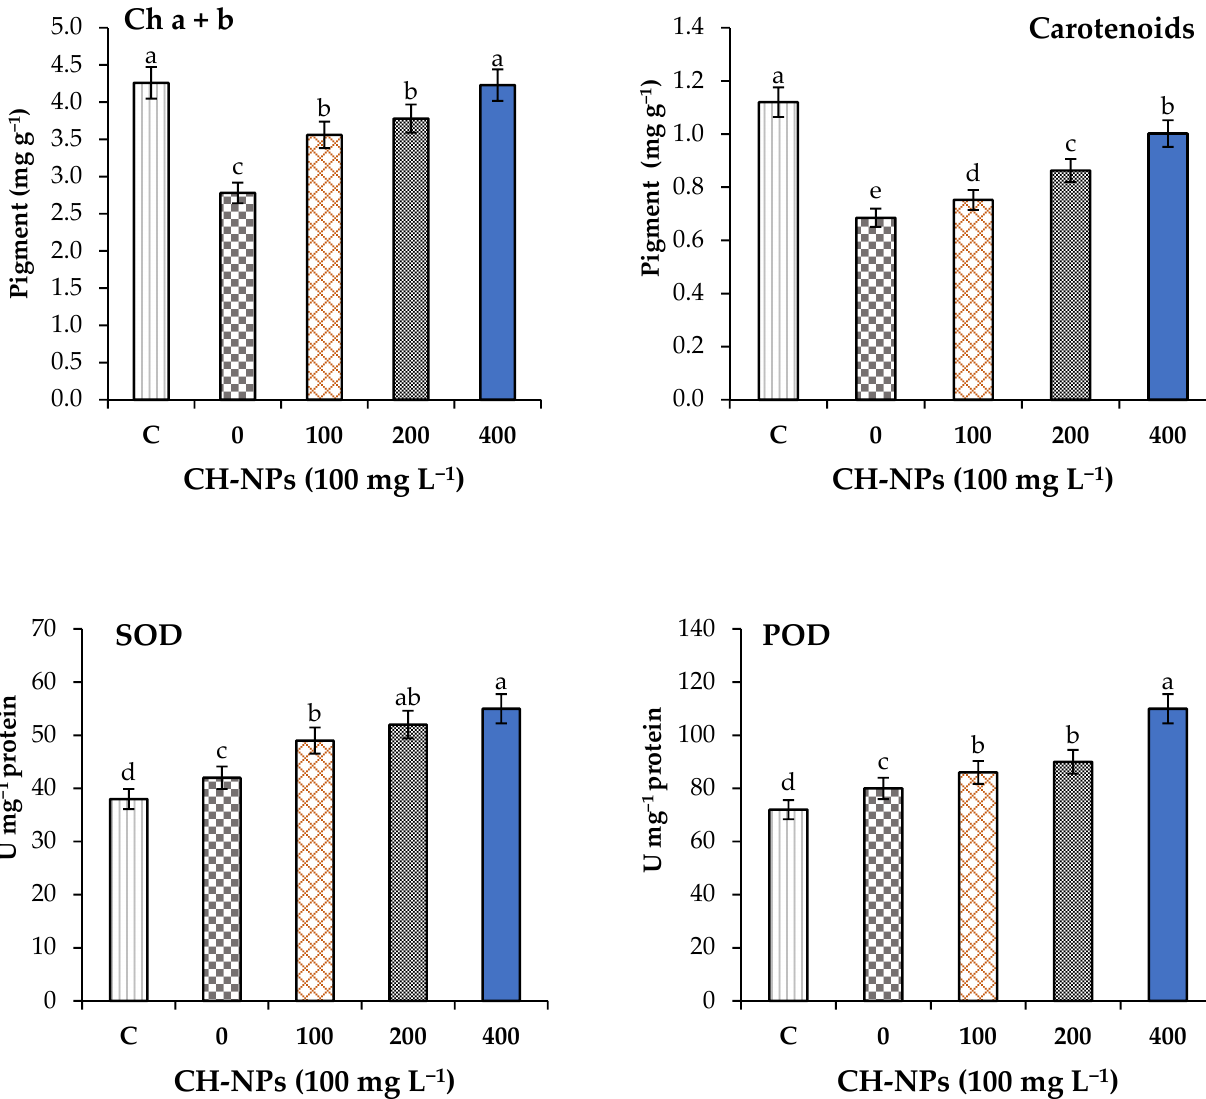
Figure 2. Effect of chitosan nanoparticles (CH-NPs) on photosynthesis pigments (Chl (a + b) and carotenoids) and antioxidant enzymes superoxide dismutase (SOD) and peroxidase (POD) of banana plants exposed to cold stress (5 ◦ C for 72 h). C = control treatment without cold stress and without CH-NPs amendment. Different letters refer to significant differences between treatments according to Tukey test at p < 0.05. Each value is the mean of five replicates (mean ± SD, n = 5). Spraying banana plants with 100 mg L − 1 of CH-NPs increased the peroxidase (POD) and superoxide dismutase (SOD) by 8 and 17%, respectively, compared to the unsprayed plants. Spraying banana plants with 200 mg L − 1 of CH-NPs increased the peroxidase (POD) and superoxide dismutase (SOD) by 13 and 24%, respectively, compared to the untreated plants. Spraying banana plants with 400 mg L − 1 of CH-NPs increased the perox- idase (POD) and superoxide dismutase (SOD) by 38 and 31%, respectively, compared to the control. CH-NPs at all the studied concentrations significantly ( p < 0.05) increased pho- tosynthesis pigments and antioxidant enzyme activities in the leaves of banana plants ex- posed to cold stress (5 °C for 72 h).